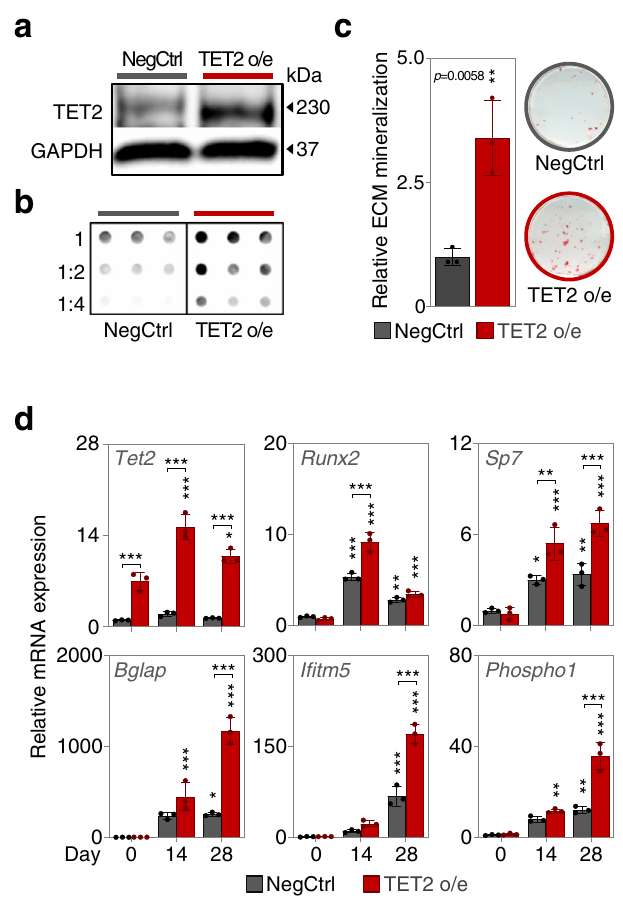
Fig. 8 | TET2 overexpression potentiates osteoblastic differentiation. a TET2 westernblotafterCRISPR-dCas9-mediated TET2o/e(overexpression) and b 5hmC dot blot under the same conditions. c ECM mineralization after TET2 o/e at day 21 of differentiation. d Osteoblastic gene expression during TET2 o/e. Bar graphs representmean±SD;* p <0.05;** p <0.01;*** p <0.001.Unpairedtwo-tailed t testin ( c ); two-way ANOVA analysis with Tukey ’ s multiple comparison tests, groups compared to D0 Ctrl or as marked in d . N =3 ( c , d ) per group, from biologically independent experiments. Source data as well as exact p =values for all compar- isons in d are provided in the Source Data